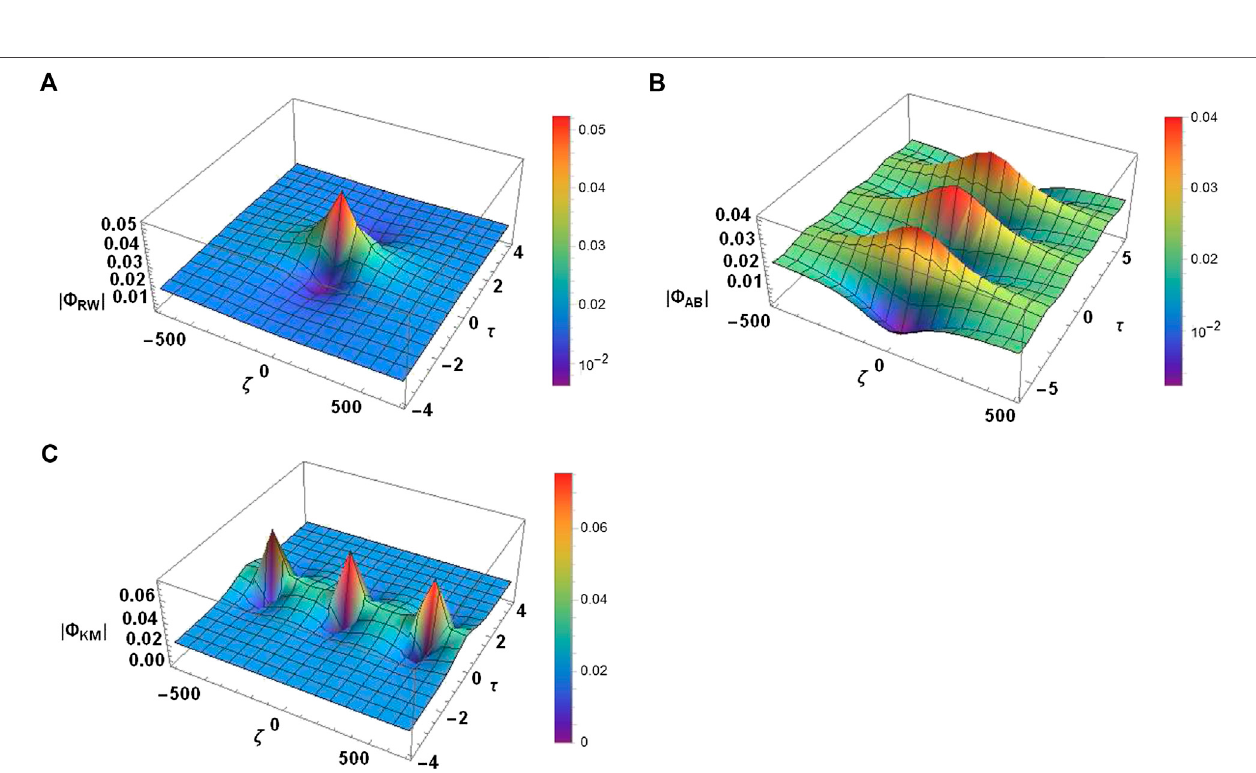
FIGURE7| The 3Dpro fi le of (A) DA roguewavesat ℵ (cid:1) 0 . 5, (B) DA Akhmediev breather at ℵ (cid:1) 0 . 2,and (C) DAKuznetsov – Mabreather at ℵ (cid:1) 2withrespect to ζ and τ whereas R (cid:1) 0 . 11, α (cid:1) 0 . 2, and ρ (cid:1) 1 . 11 are fi xed.